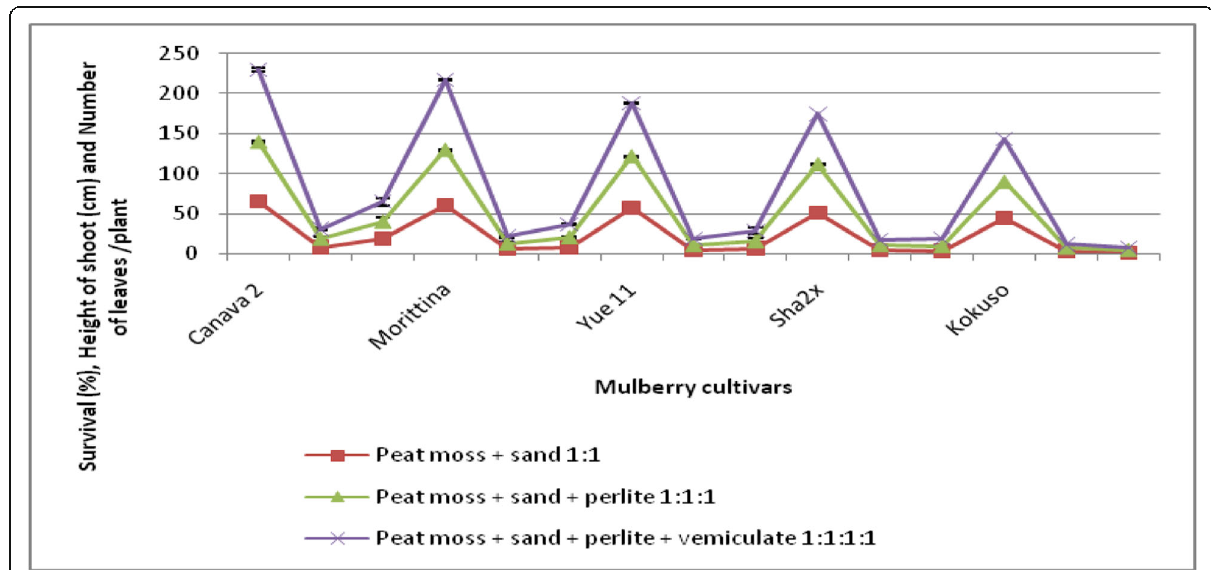
Fig. 6 Influence of different potting mixture media on the growth survival (%), height of shoots (cm), and number of leaves/plant of in vitro derived mulberry cultivar plants. Each treatment is the average of 3 replicates ± SE